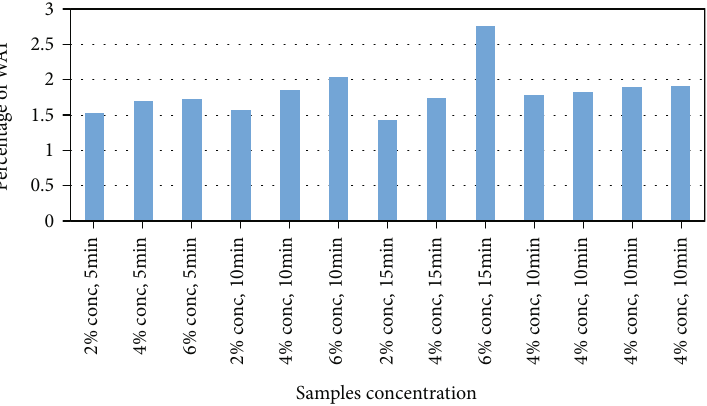
Figure 3: Water absorption index of the sample